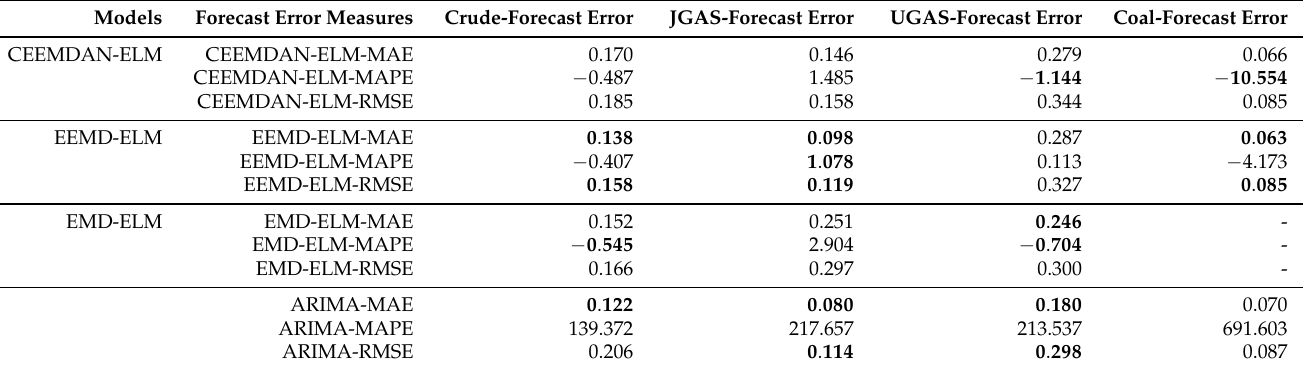
Table 5. Forecasting performance based on MAE, MAPE, and RMSE during COVID-19 outbreak.